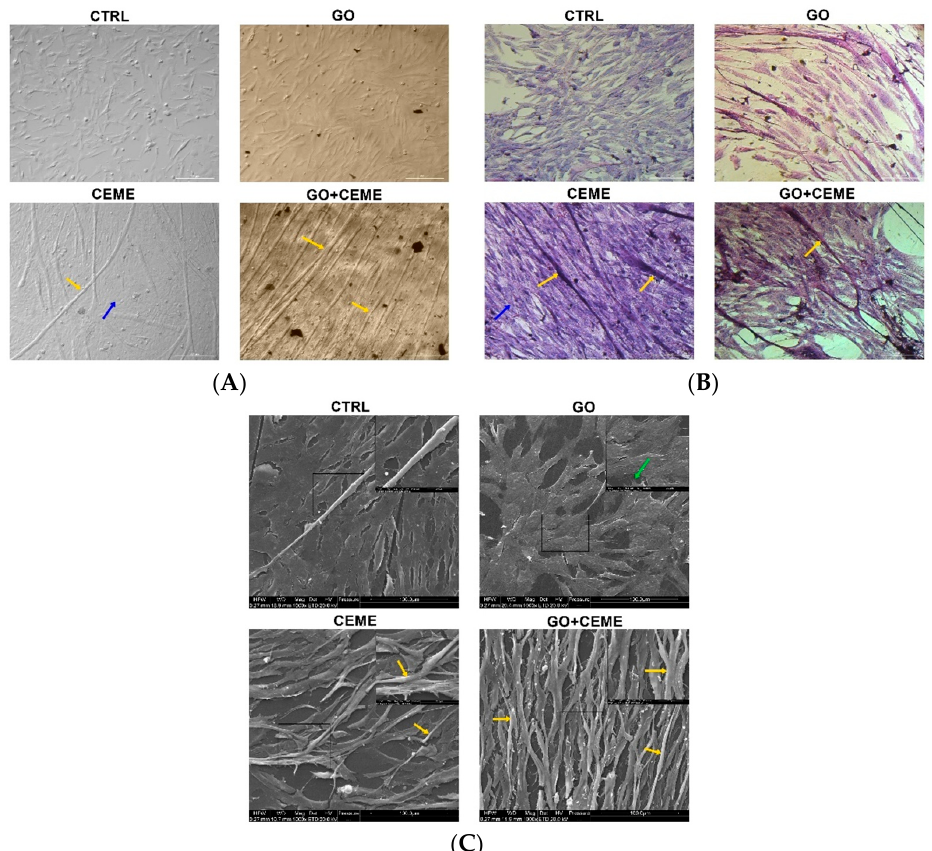
Figure 3. Cell morphology evaluated by optical microscopy ( A, B ) and scanning electron microscopy ( C ); the images show the control group (CTRL), cells cultured on graphene oxide nanofilm (GO), cells cultured with the addition of the extract (CEME), and cells cultured on GO nanofilm with addition of the extract (GO + CEME); cells were stained with eosin/hematoxylin for visualization of nucleic acids and proteins ( B ); myotubes (yellow arrows), filopodia (green arrow); multilayer of undifferentiated cells (blue arrows).